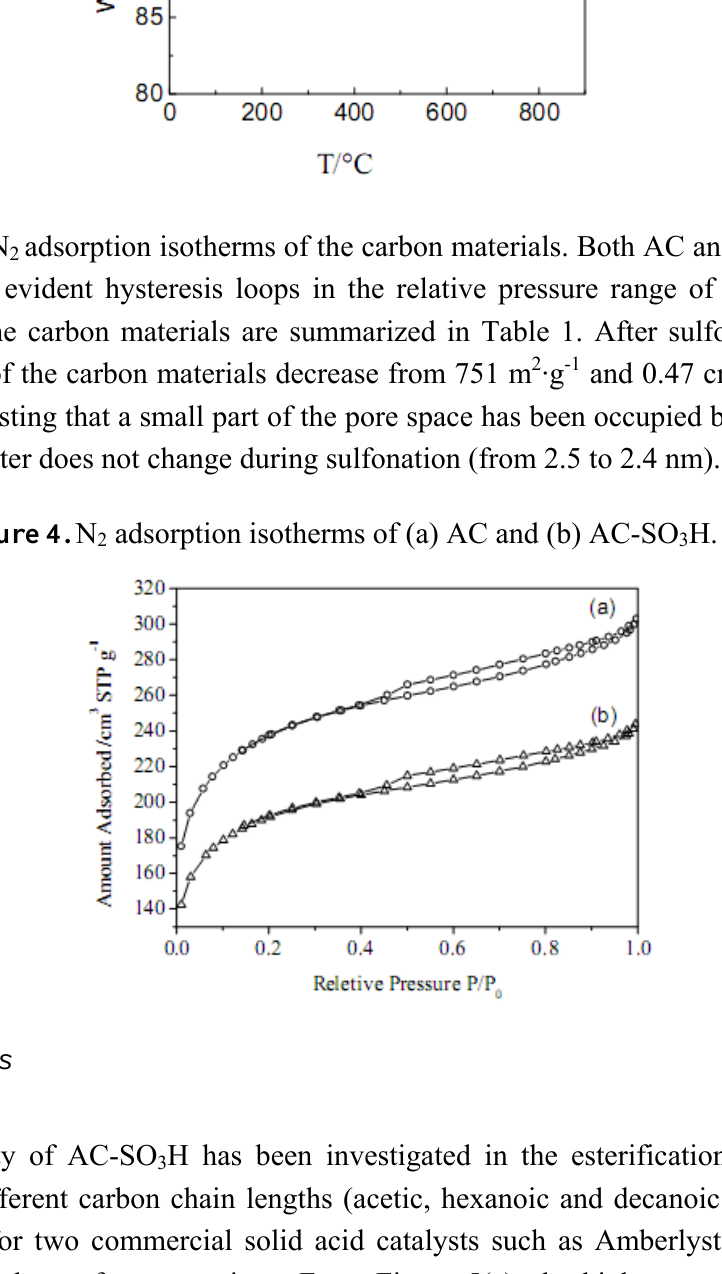
Figure 3. Thermogravimetric profiles for (a) AC, (b) AC-SO